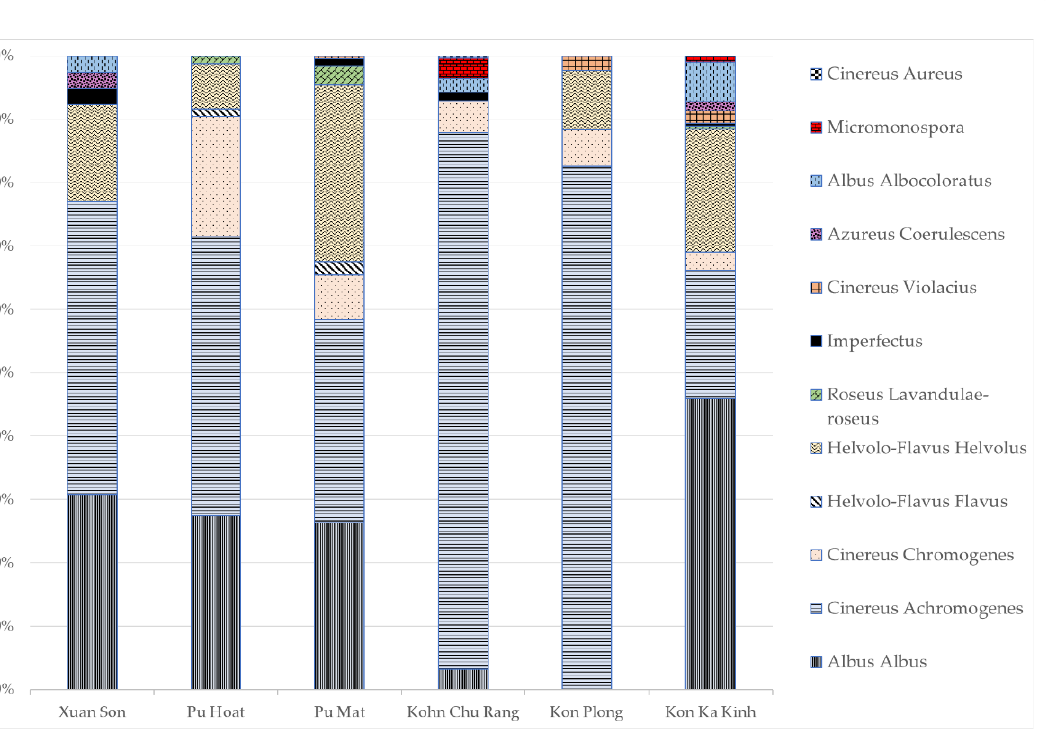
Figure 3. The taxonomic composition of actinomycete complexes at the section and series level based on morphological characteristics of cultured actinomycetes. The figure shows percentage content of the actinomycete section (Y-axis) in the actinomycete complex of protected area (X-axis). In the Pu Hoat Nature Reserve, which is located south of Xuan Son, two types of soils were analyzed: alluvial brown and mountainous red-yellow humus–ferrallitic.